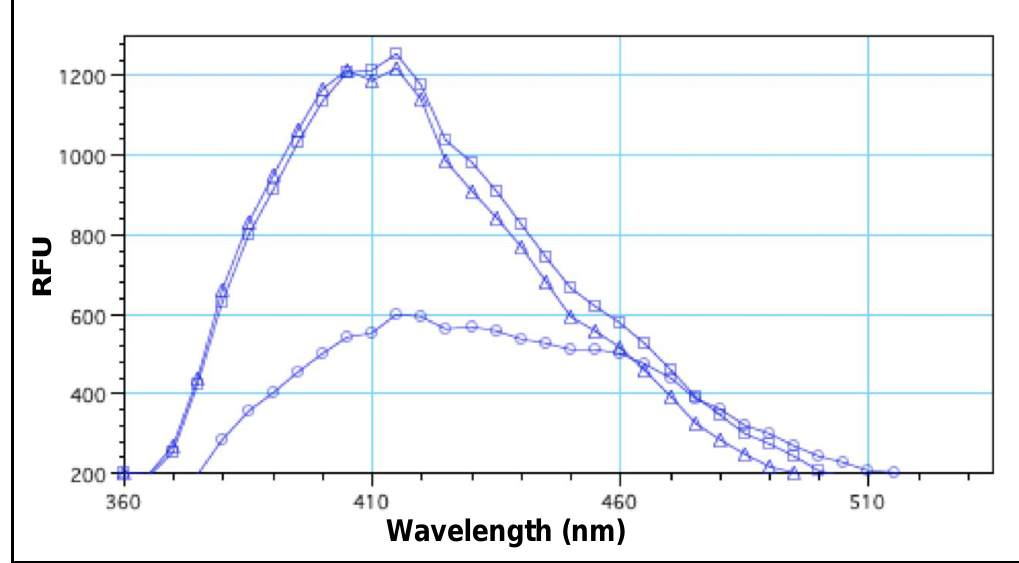
Figure A2. rAgamOBP1 activity after 5 years of storage. 10 µM rAgamOBP1 in 50 mM Tris-HCl pH 7.4 tested for response in the Attenu assay system with the fluorescent dye, 1-NPN, that binds to the protein and results in a signal that is detectable spectrophotometrically. Data shown as collected directly from the Gemini XPS spectrofluorometer (Molecular Devices, Sunnyvale, CA, USA). x- axis: wavelength in nm; y- axis: response units. Open circle: control (5 µM 1-NPN in 50 mM Tris-HCl pH 7.4); open square: freshly-purified 10 µM rAgamOBP1 with 5 µM 1-NPN in 50 mM Tris-HCl pH 7.4; open triangle: stored 10 µM rAgamOBP1 with 5 µM 1-NPN in 50 mM Tris-HCl pH 7.4. The rAgamOBP1 had been stored in 50 mM Tris-HCl pH 7.4 for 5 years. Table A1. Raw numbers and statistical analysis of the data shown in Figure 1. Area under the response curve from the Attenu assay is shown in the first 6 rows. The indole derivative is listed on top. Averages and statistical analysis are shown in the last 3 rows.